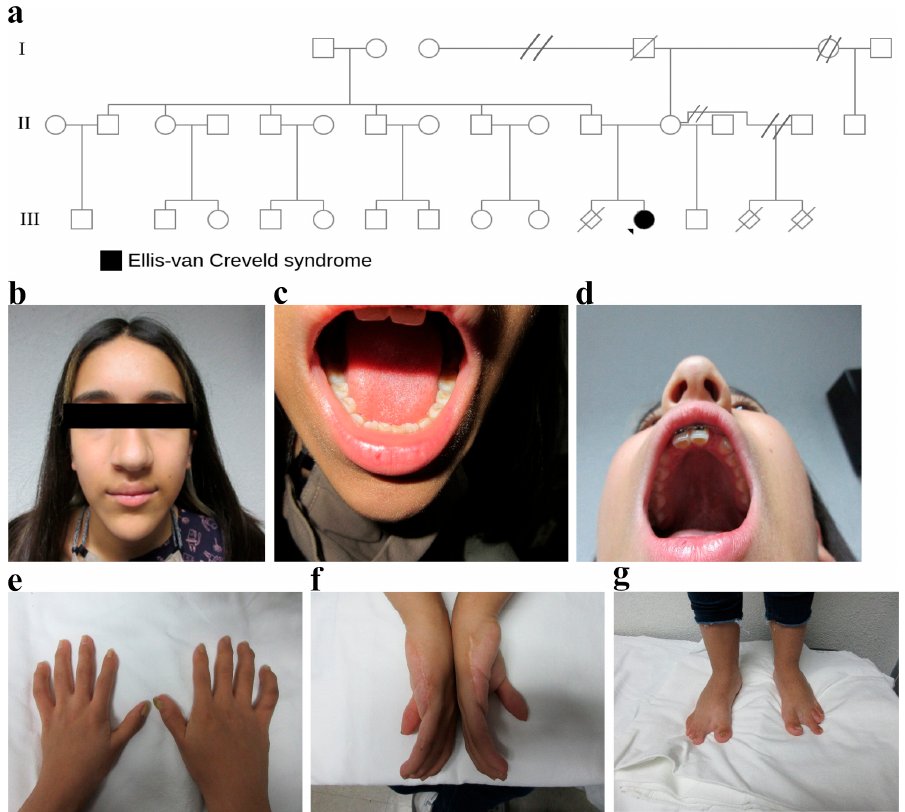
Figure 2. Clinical features of a patient with EvCS. ( a ) Pedigree of a Mexican family with an autosomal recessive EVC2 variant. The fully shaded symbol shows the patient with EvCS (III:11). ( b ) A normal nasal bridge, a straight nasal septum, a bulbous nasal tip, a wide columella, and a short philtrum. ( c , d ) An oral cavity with an intact palate, a central uvula, and hypodontia. ( e ) Brachydactyly, bilateral dysplastic thumb nails, and wide fingers. ( f ) A resection scar in the ulnar region of both hands. ( g ) In the lower limbs—dysplastic nails, bilateral increased space between the first and second toes, a bilateral second long toe, and genu valgum.